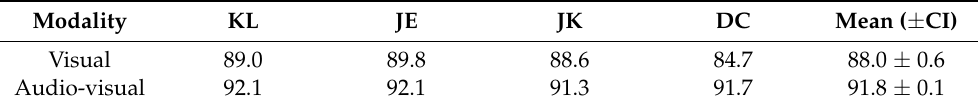
Table 1. Average human classification accuracy